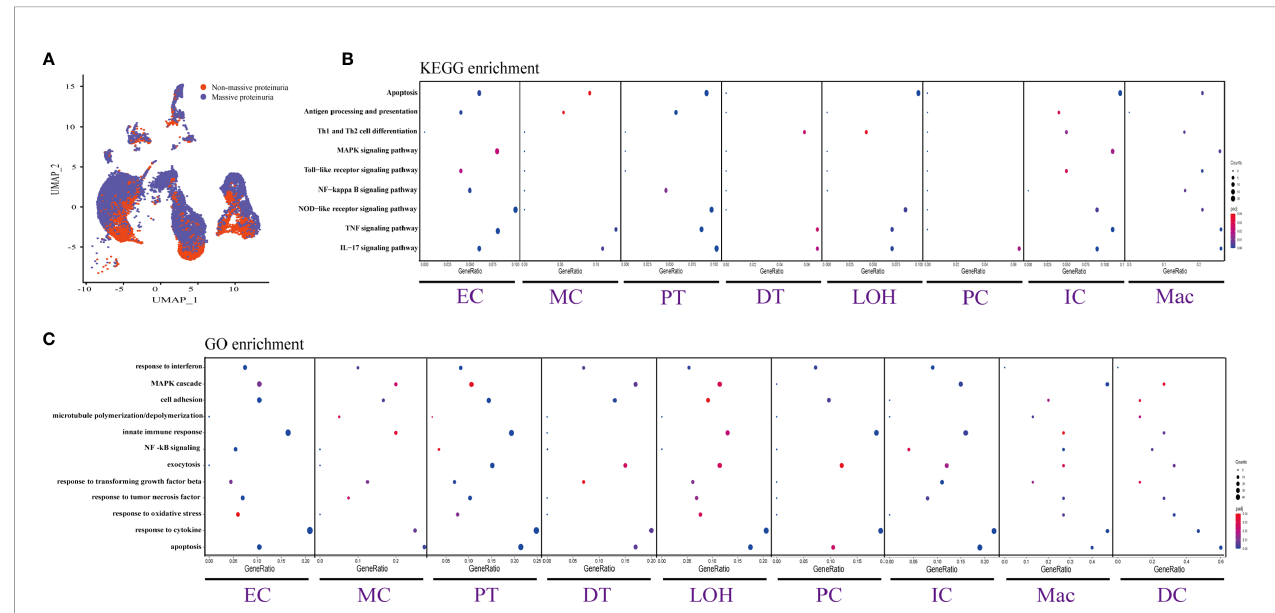
FIGURE 4 | DEGs involved in biological process and intercellular signaling in the kidney from anti-PLA2R positive IMN patients with massive proteinuria compared to non-massive proteinuria. (A) UMAP plot of cell clusters between massive proteinuria and non-massive proteinuria. The color of cells re fl ected different groups. (B, C) KEGG and GO enrichment analysis showed that upregulated DEGs were mostly involved in apoptosis, cell adhesion, and regulation of in fl ammation and the immune response in massive proteinuria patients, compared with non-massive proteinuria